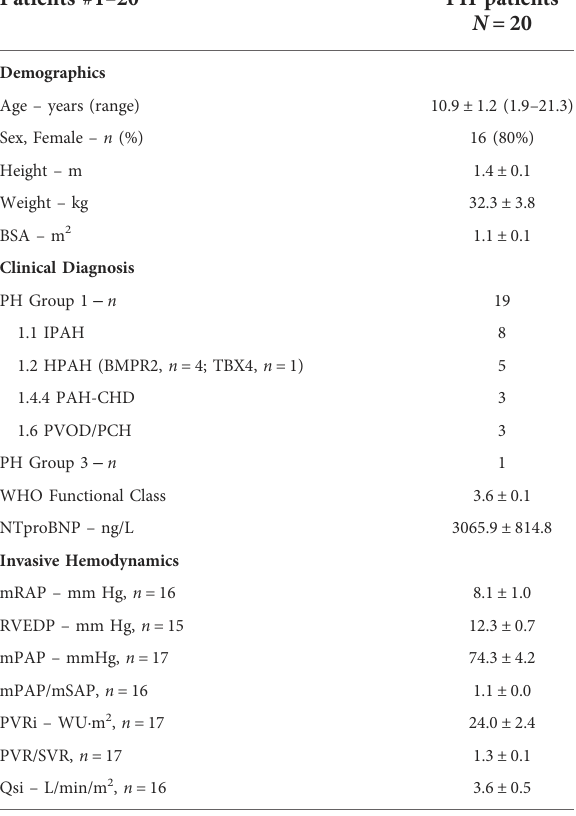
TABLE 1 Characteristics of the 20 PH patients